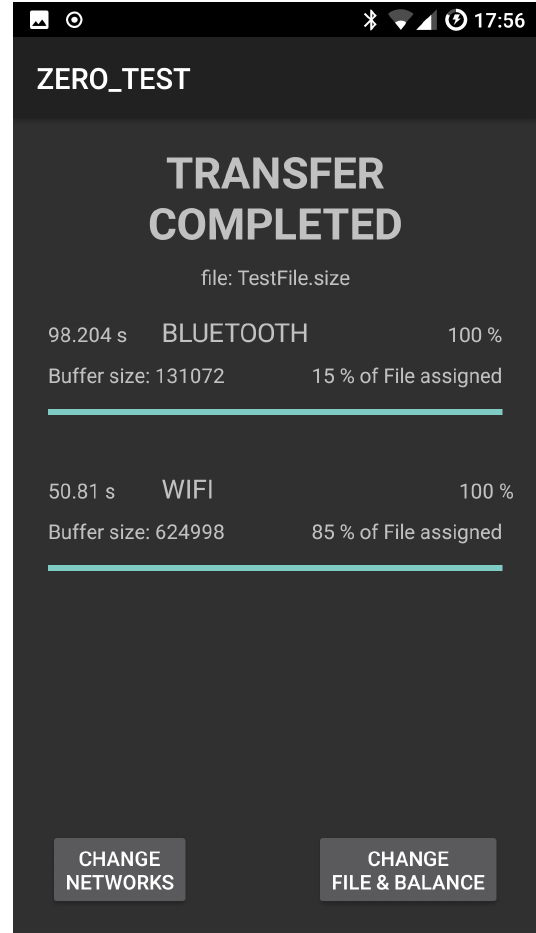
Figure 11. File upload and balance